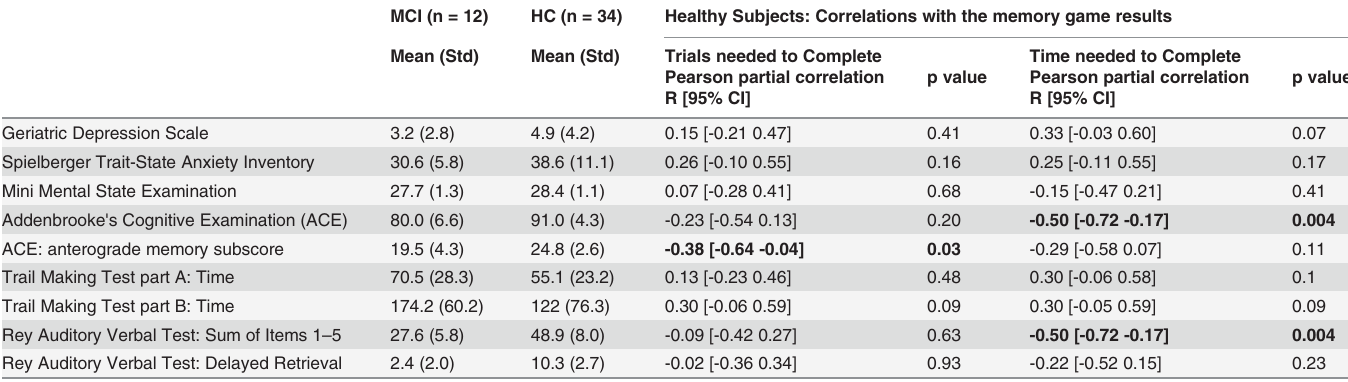
Table 1. Results of the neuropsychological tests and correlations with the results of the memory game.